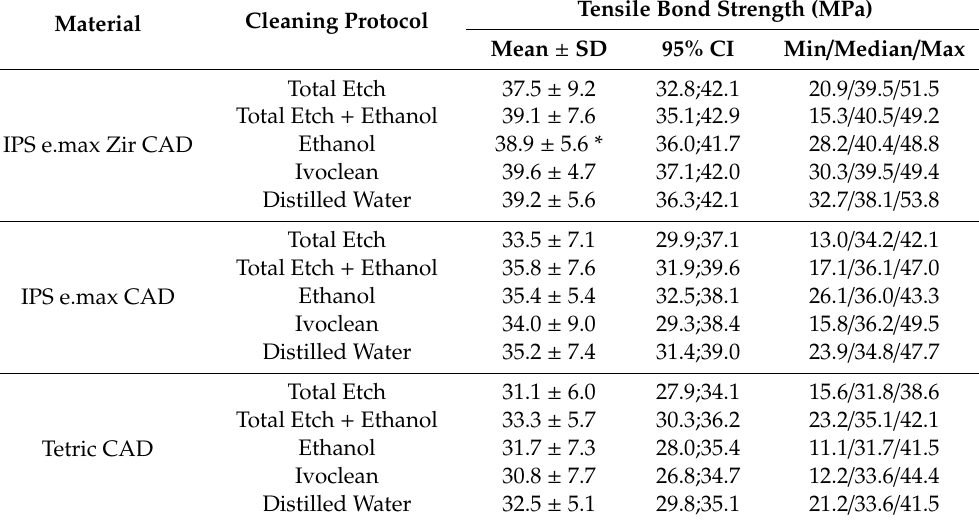
* indicates deviation from normal distribution.